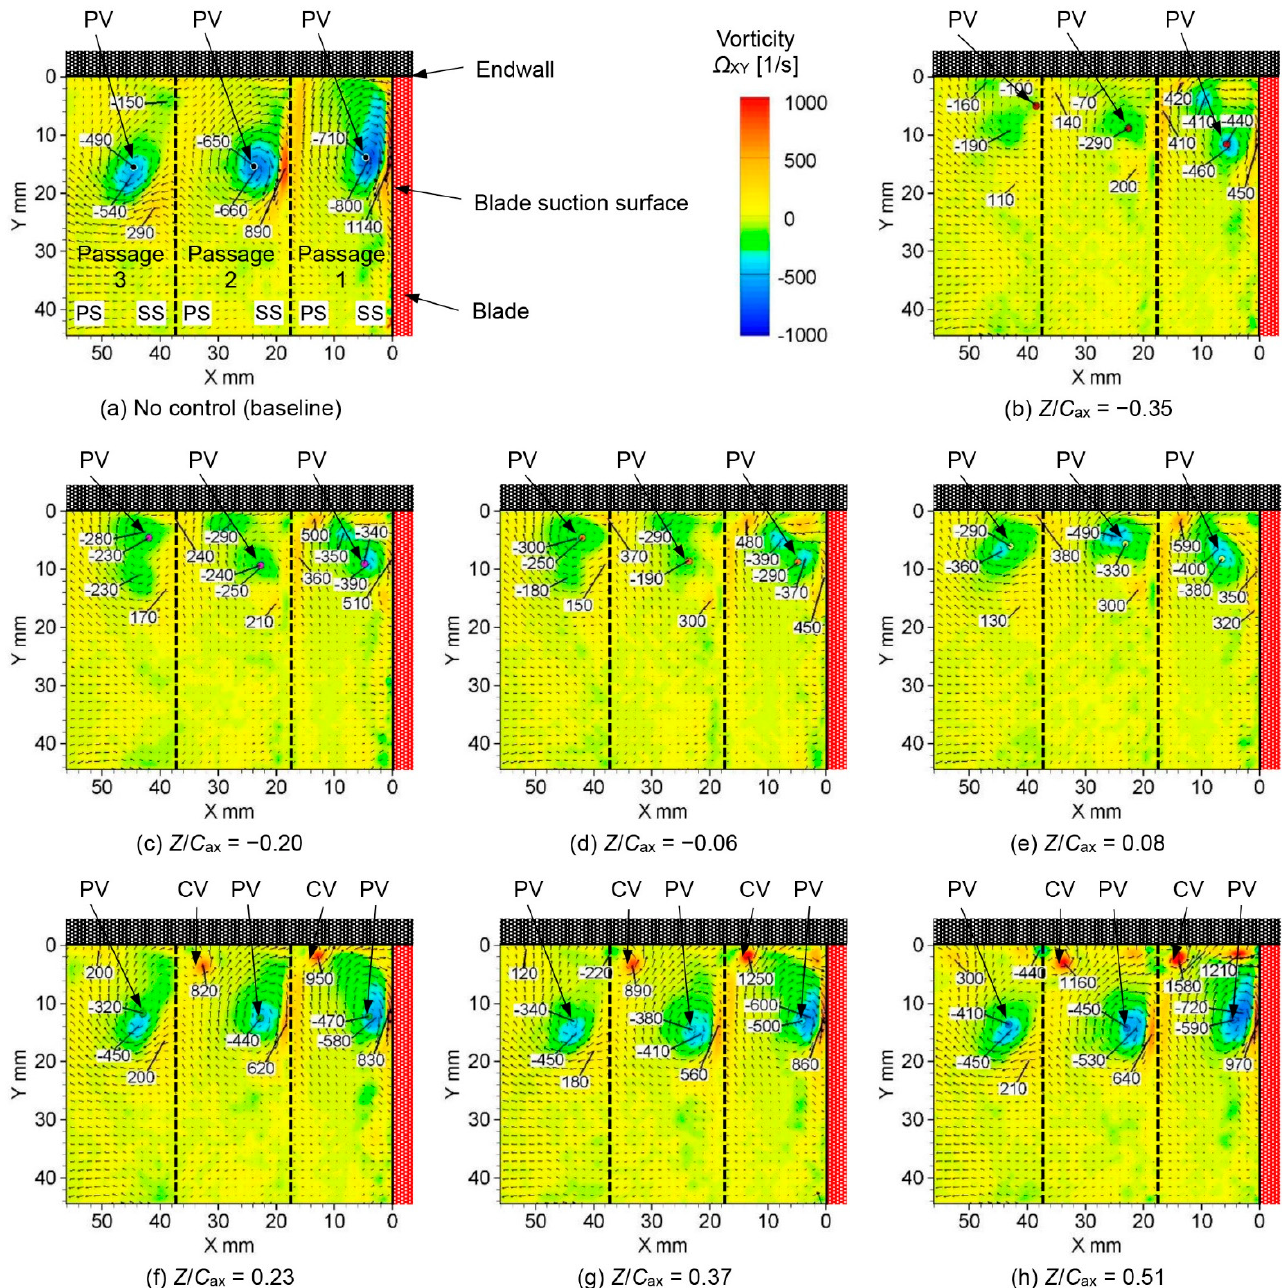
Figure 14. Vorticity distributions of secondary flow at the outlet of the linear turbine cascade at various plasma actuator locations (Re out = 1.8 × 10 4 ).